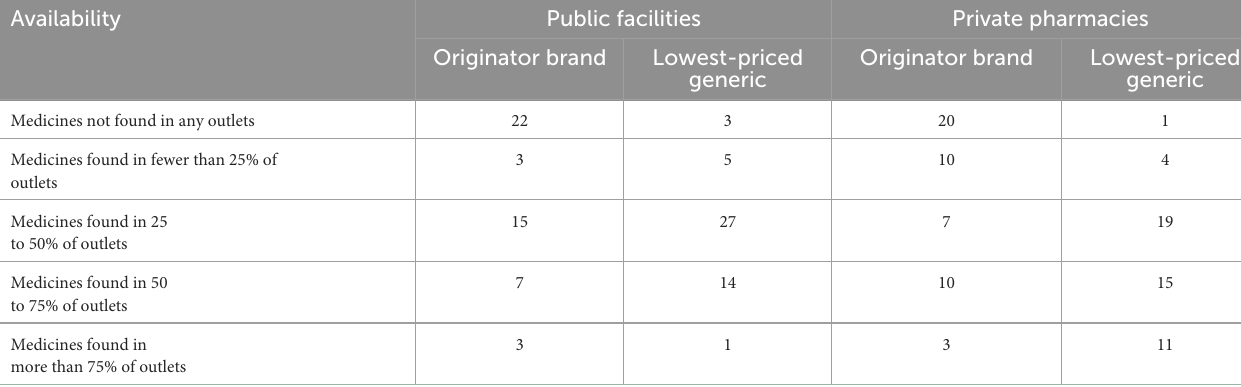
TABLE 2 Availability of medicines in the public sector and the private